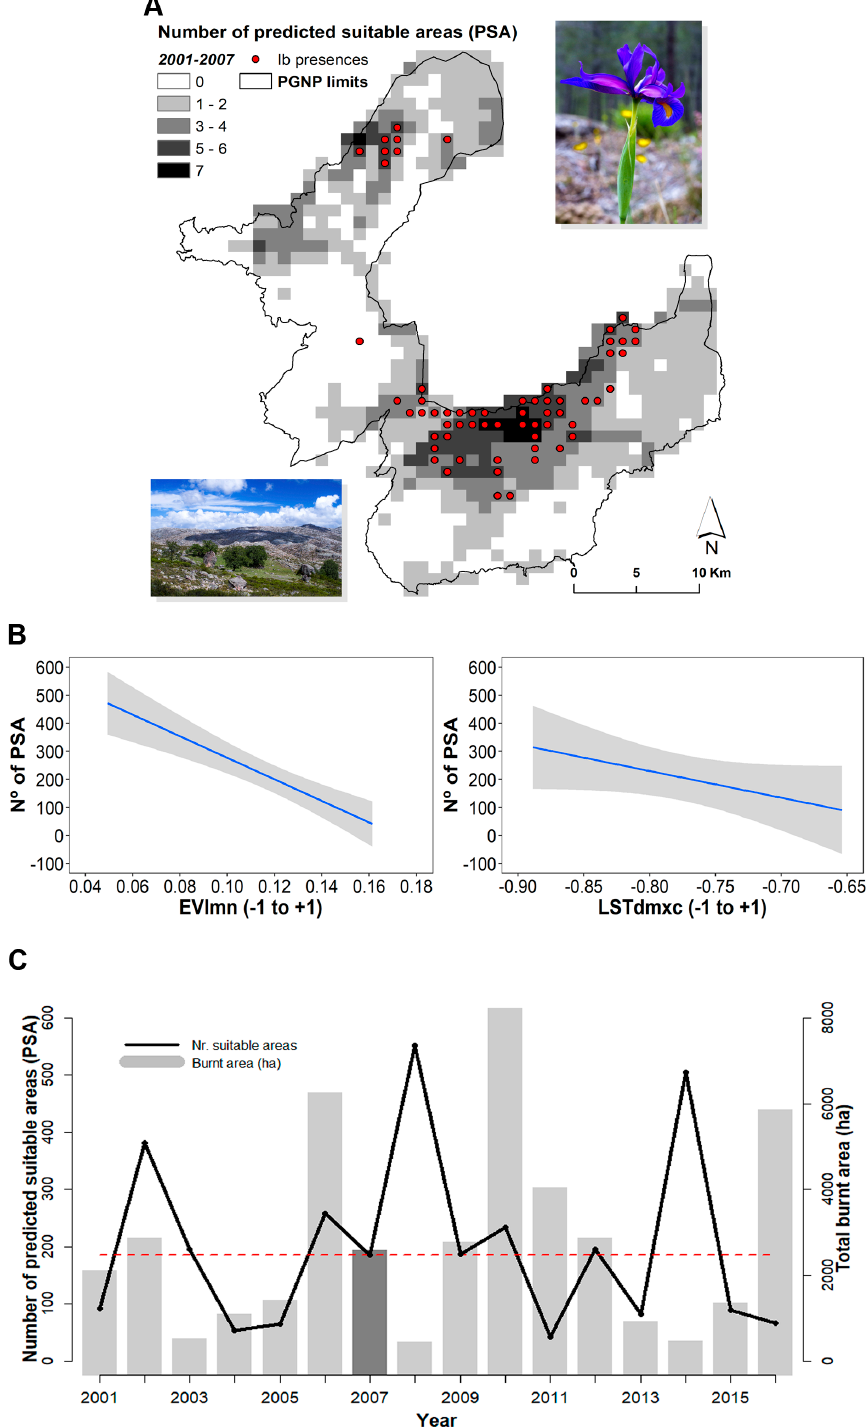
Figure 6. ( A ) Distribution of predicted suitable areas (PSA) between 2001 and 2007 by classes for each grid unit (1 km 2 ) for Iris boissieri in PGNP. Pictures from Iris boissieri and suitable habitat gently provided by ADERE association (http://www.adere-pg.pt/?lg=2). ( B ) Response curves of the two main contributing predictors: EVImn (enhanced vegetation index annual minimum) and LSTdmxc (cosine of the date of maximum land surface temperature) with PSA. ( C ) Interannual variation of PSA (black line) and PSA predictions for 2007, year with observed presences (dashed red line), along with auxiliary data related to the total amount of burned area in the study site each year (grey bars).